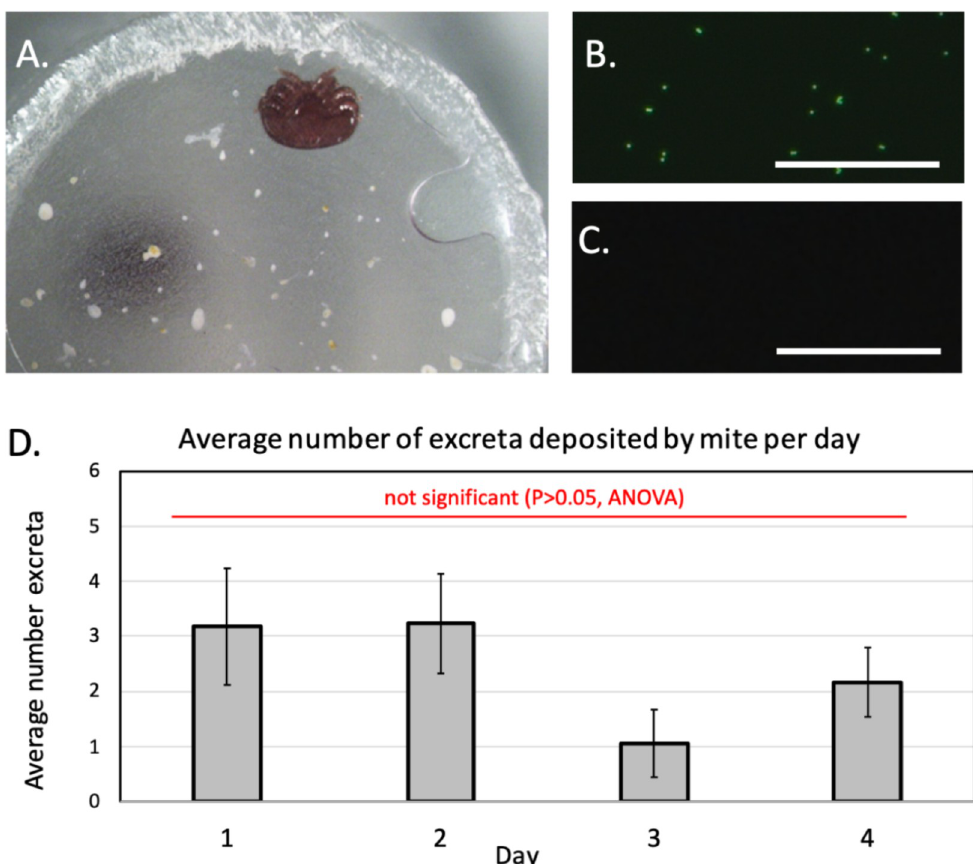
Fig 4. Evidence supporting Varroa mites fed on the artificial diet. (A) Photograph shows the parafilm membrane with a live mite attached and numerous excretory deposits. (B) Micrograph showing fluorescent microbeads in mite feces collected from devices housing mites provided diet containing microbeads. (C) Micrograph showing no fluorescent microbeads in mite feces collected from devices housing mites provided diet containing no microbeads. (D) The mean ( ± SE) total daily number of excretions deposited by mites on the membrane sachet. Measurement bar = 50 μ M.